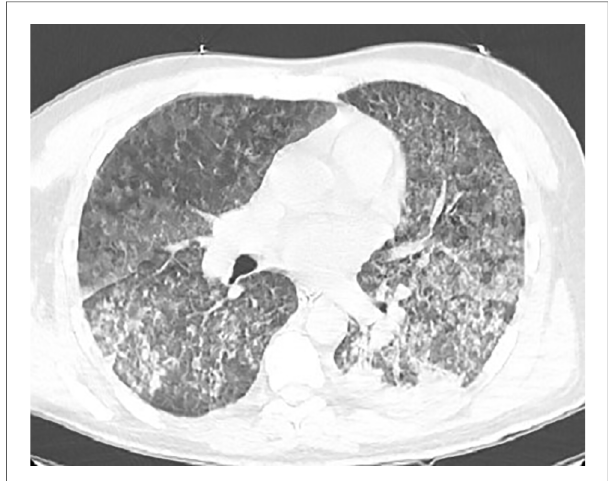
FIGURE 1 Chest CT Scan showing diffuse bilateral patchy alveolar in fi ltration with interlobular septal thickening and consolidation mostly seen at the posterior aspect of the lungs representing alveolar